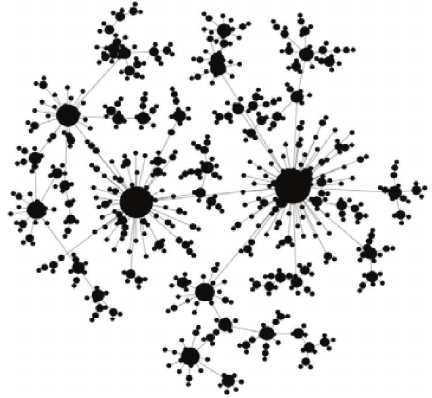
Figure 2: Networks of opinions spread.